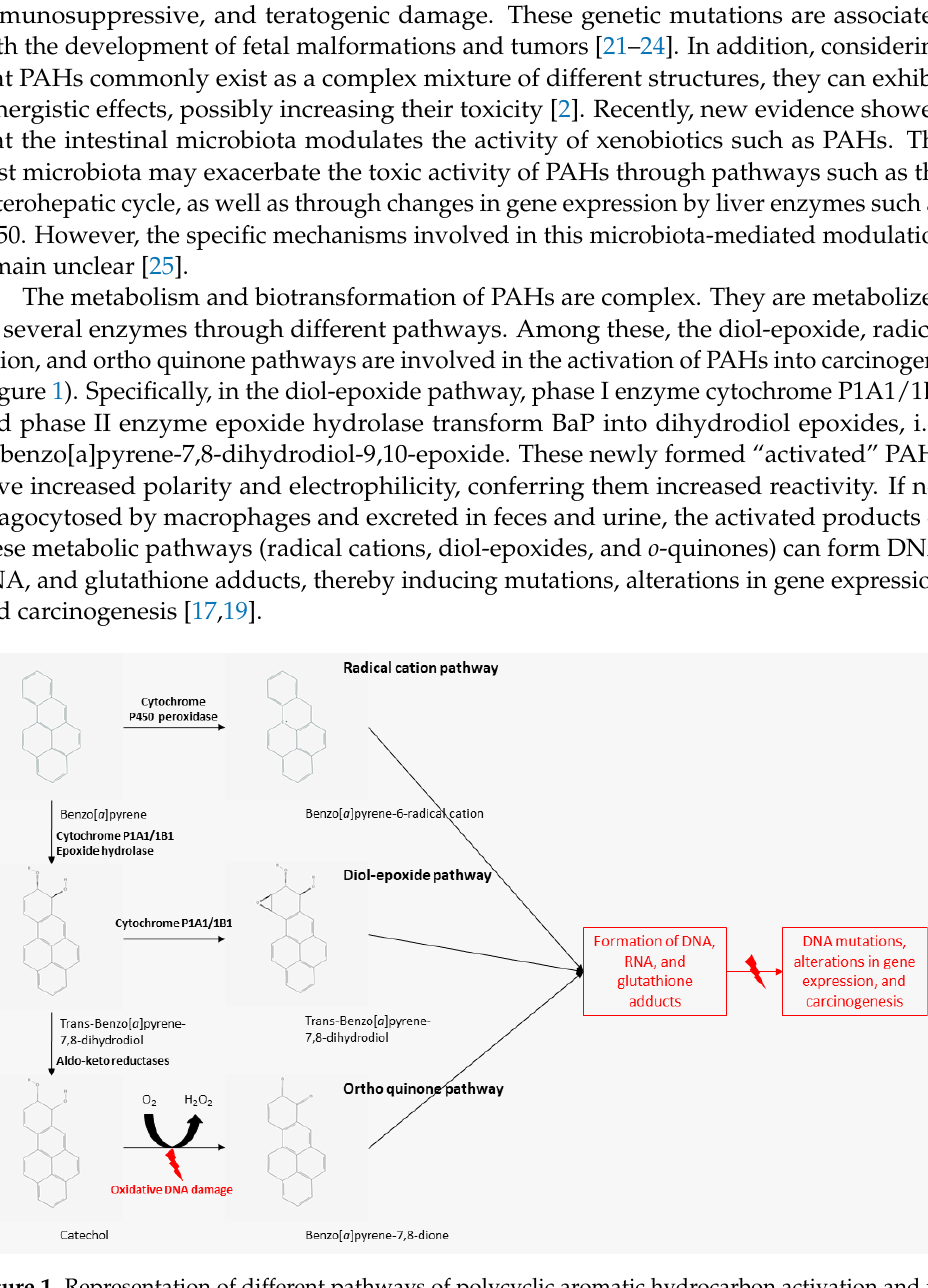
Figure 1. Representation of different pathways of polycyclic aromatic hydrocarbon activation and its effects on human health. Based on information from [17,19].